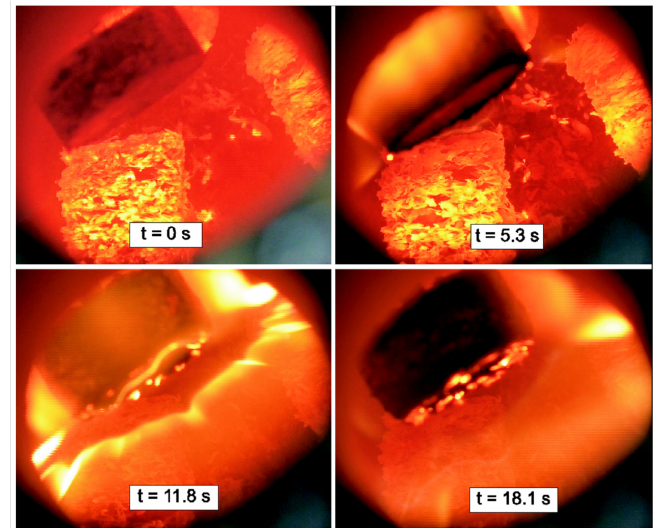
Figure 2. Ignition and combustion of